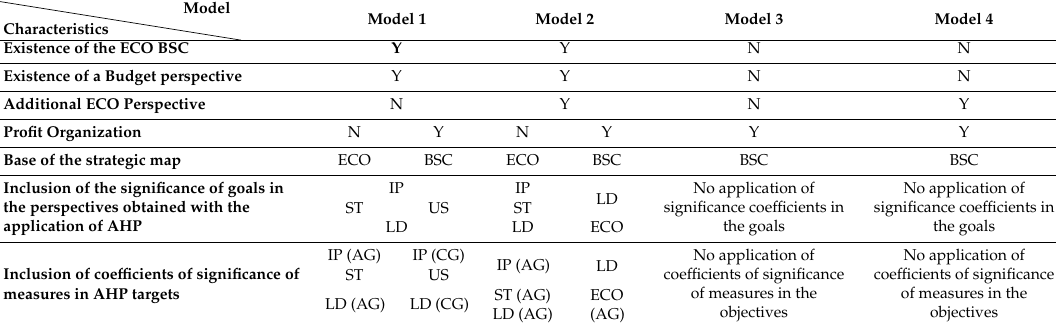
Table 3. Details in the comparative analysis of the 4 recommended BSC models.